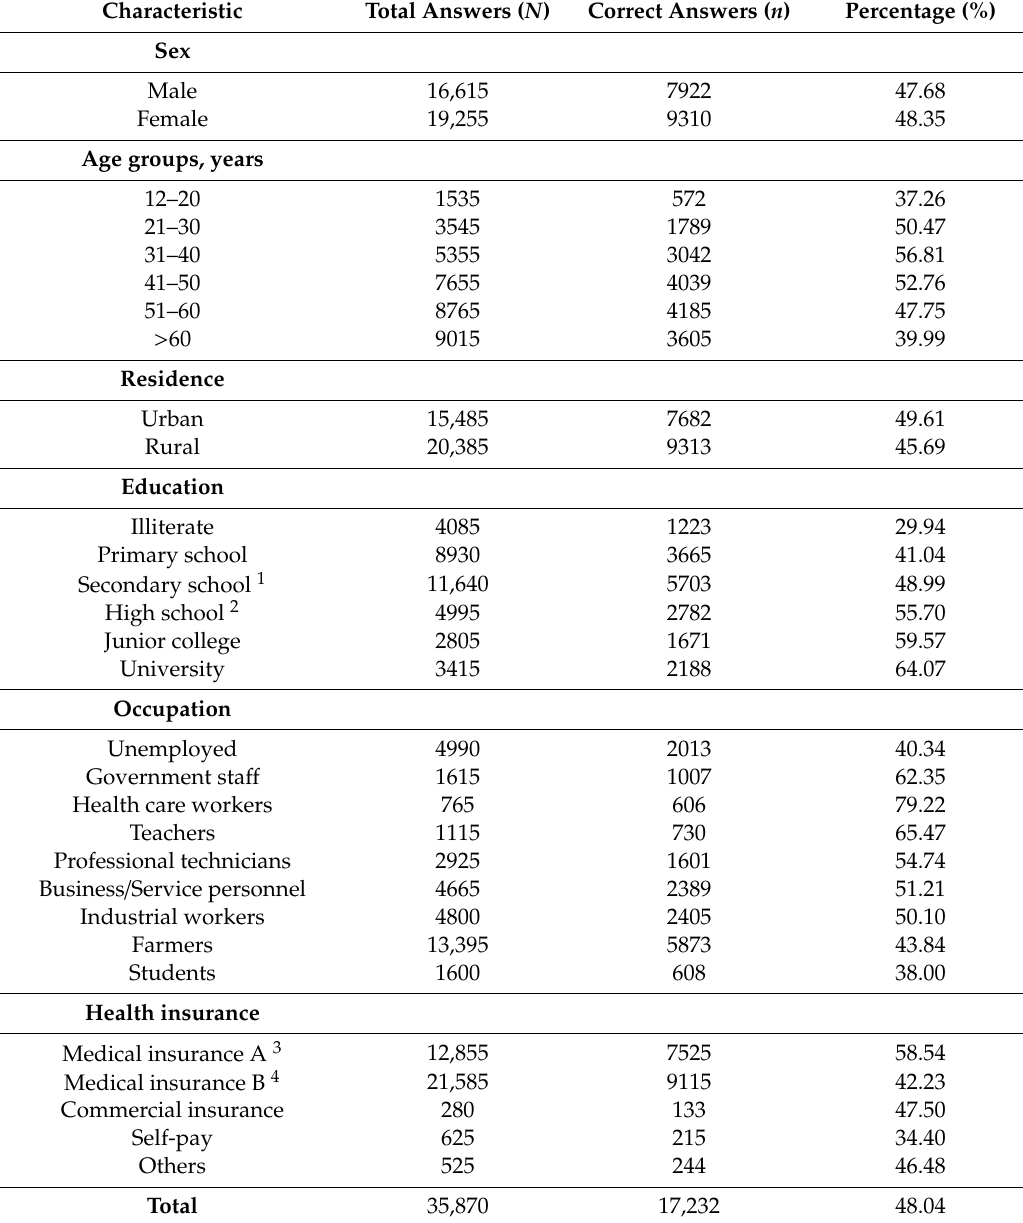
Table 3. Rate of awareness of key knowledge about TB among respondents with di ff erent characteristics in Zhejiang Province, China from October 2018 to December